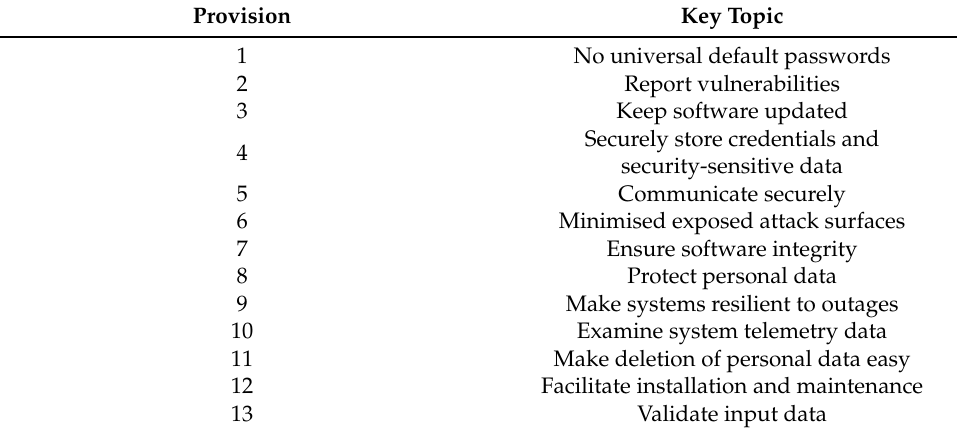
Table 1. ETSI technical specifications. Cybersecurity for consumer